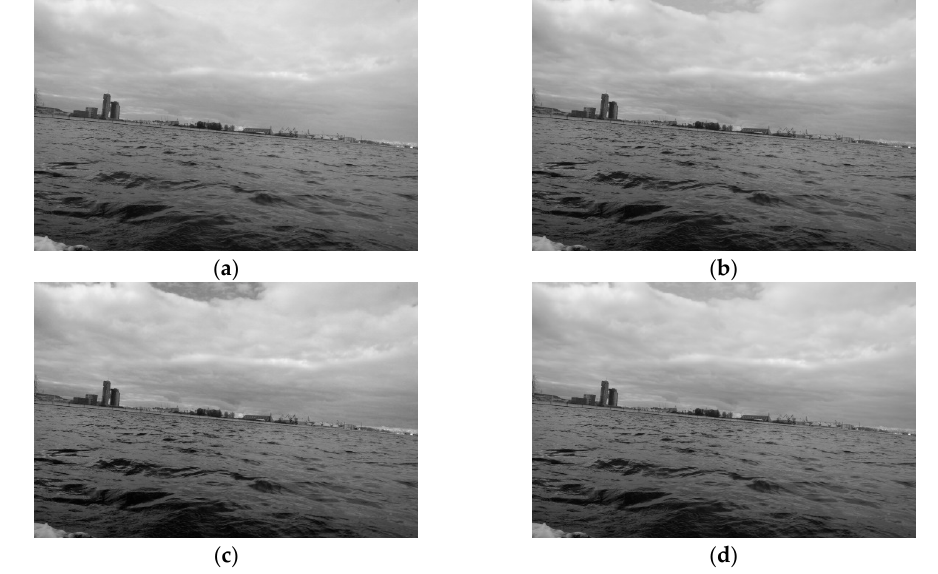
Figure 1. ( a ) Channel V of the HSV colour model; ( b ) Channel B of the RGB colour model; ( c ) Channel R of the RGB colour model; ( d ) A grey channel obtained using the conversion formula.